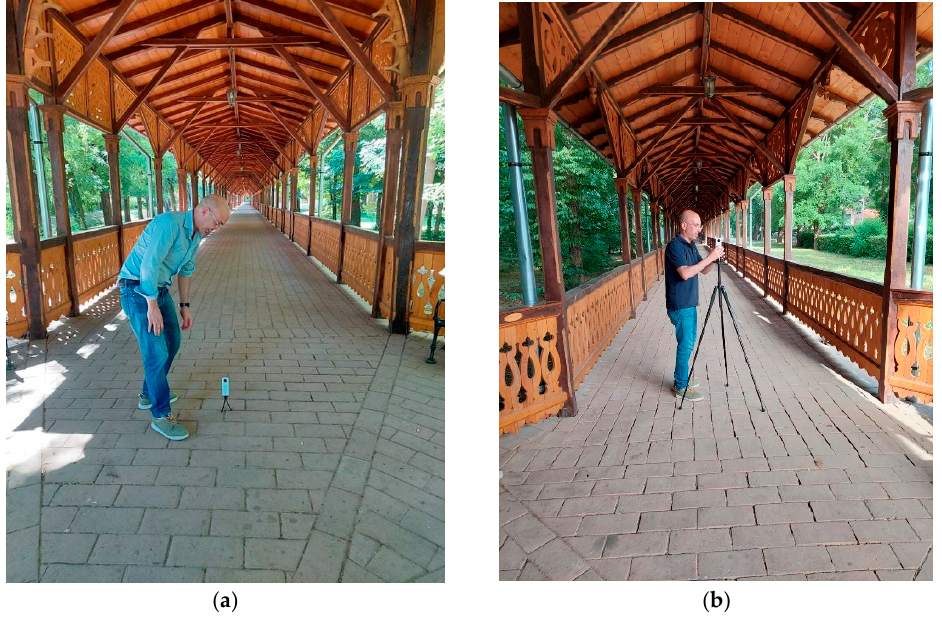
Figure 6. Survey by Ricoh Theta SC2: ground level ( a ) and tripod level ( b ).